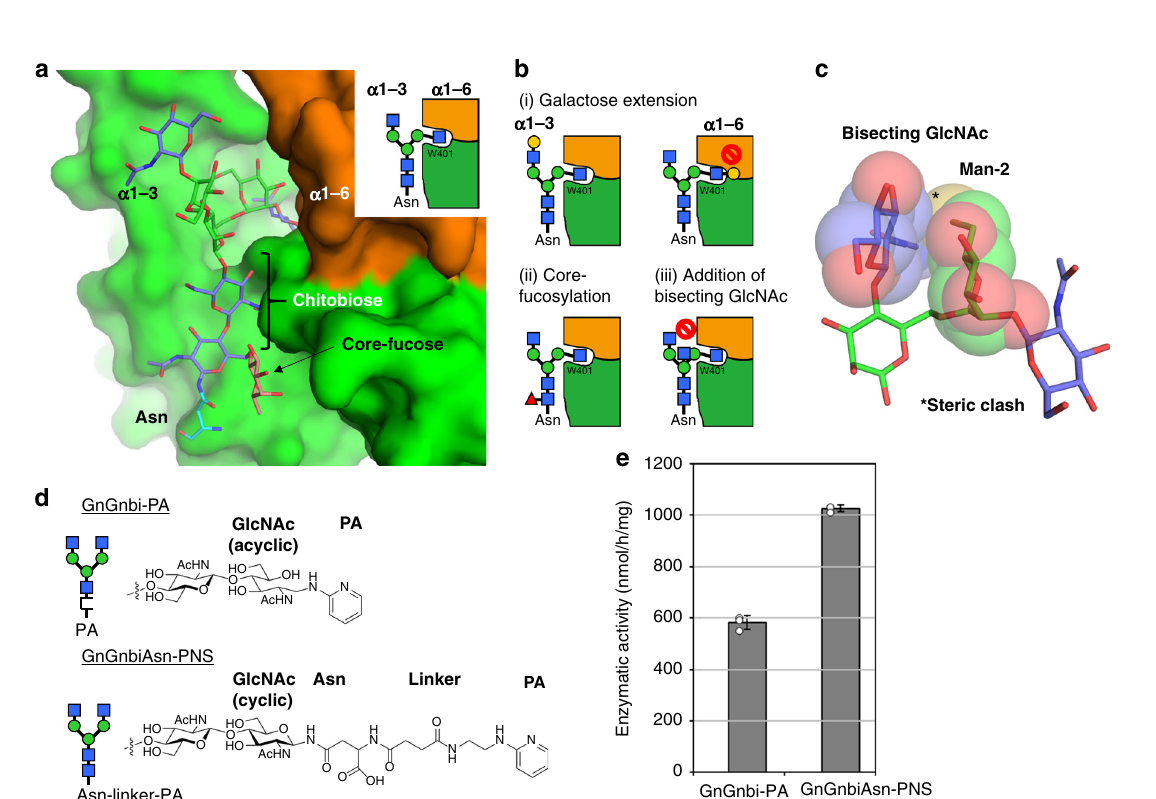
Fig. 4 Substrate speci fi city of GnT-V toward various types of N -glycans. a Docking model of N -glycan bearing α 1-3 branch, chitobiose, core fucose, and asparagine. Sugar residues and GnT-V are shown in rod and surface models, respectively. Schematic drawing of interaction mode is also shown in right panel. Structure of N -glycan was built based on the atomic structures of biantennary glycans (PDB codes: 5XFI 77 and 4BM7 78 ). b Schematic drawing of interaction modes in various types of N -glycans. (i) Galactose extension at two branches, (ii) core fucosylation, and (iii) addition of bisecting GlcNAc are shown. Structural details of these interactions are also shown in Supplementary Figures 7 and 8. c Superposition of bisecting GlcNAc onto trisaccharide structure shown in rod model. Bisecting GlcNAc and Man-2 are also shown in semi-transparent spheres. Steric con fl ict is indicated with asterisk. d Two differently labeled biantennary N -glycans applied to enzymatic assays. The oligosaccharide-type glycan (GnGnbi-PA) and asparagine-type glycan (GnGnbi- Asn-PNS) are shown in upper and lower panels, respectively. Schematic drawing of labeled glycans and close-up view of chemical structures around chitobiose unit of two substrates are also shown in left panel. e Enzymatic activity of GnT-V luminal domain toward the two types of substrates (100 pmol each per reaction) is shown. Activity was repeatedly measured ( n = 3) using the same enzymes and substrates ( n = 3). The graph shows means ±